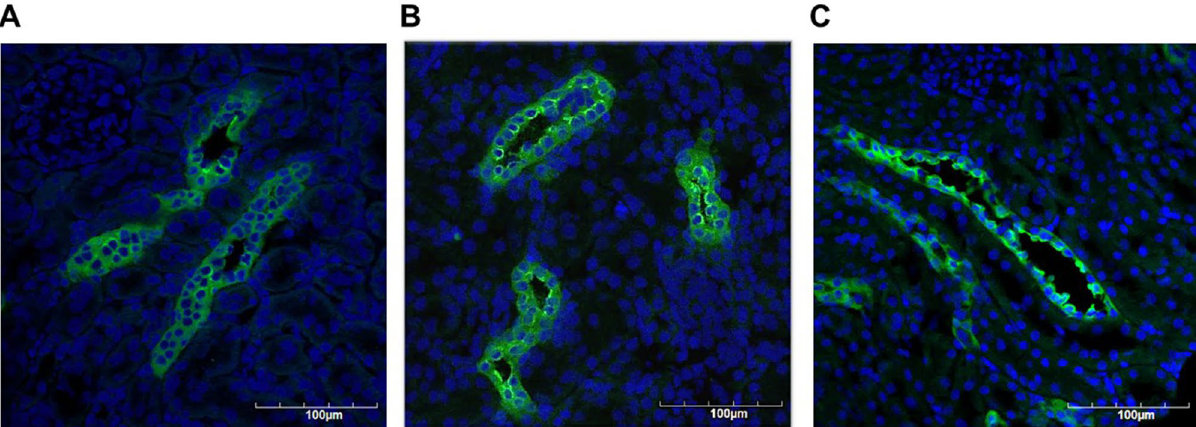
Figure 7. The changes in the distribution of AQP2 in the collecting ducts of the kidney are shown. Saline was intravenously administered to rats for 2 h to exert a water load, and 1 h after the subsequent administration of VE, IM, or dDAVP, sample kidneys were harvested. AQP2 was distributed in the cytoplasm of the collecting duct cells of the cortex in the VE-treated rats ( A ). In the rats treated with IM, AQP2 was more accumulated on the luminal side than the cytoplasm of the collecting duct cells ( B ). dDAVP caused the AQP2 molecule to localize to the luminal side of the collecting duct cells ( C Changes in cAMP contents. The level of cAMP before the saline administration (the non-diuretic state; control) was the same as that in the diuretic state. The administrations of IM (3 × 10 −1 mg/kg) and dDAVP (1 µg/kg) sig- nificantly increased the cAMP content in the renal cortex compared to VE (Fig. 6A). No significant increase was observed in the medulla (Fig. 6B). Immunolocalization of AQP2 in the rat kidney. After saline was administered to rats, the AQP2 accumulation was distributed in the cytoplasm of collecting duct cells (Fig. 7A). We observed that AQP2 accumulated on the luminal side of the collecting duct in the rats treated with IM compared to the distribution in the cytoplasm after water loading (Fig. 7B). When dDAVP was administered to rats after saline loading, AQP2 molecules migrated to the luminal plasma membrane of collecting duct cells (Fig. 7C).